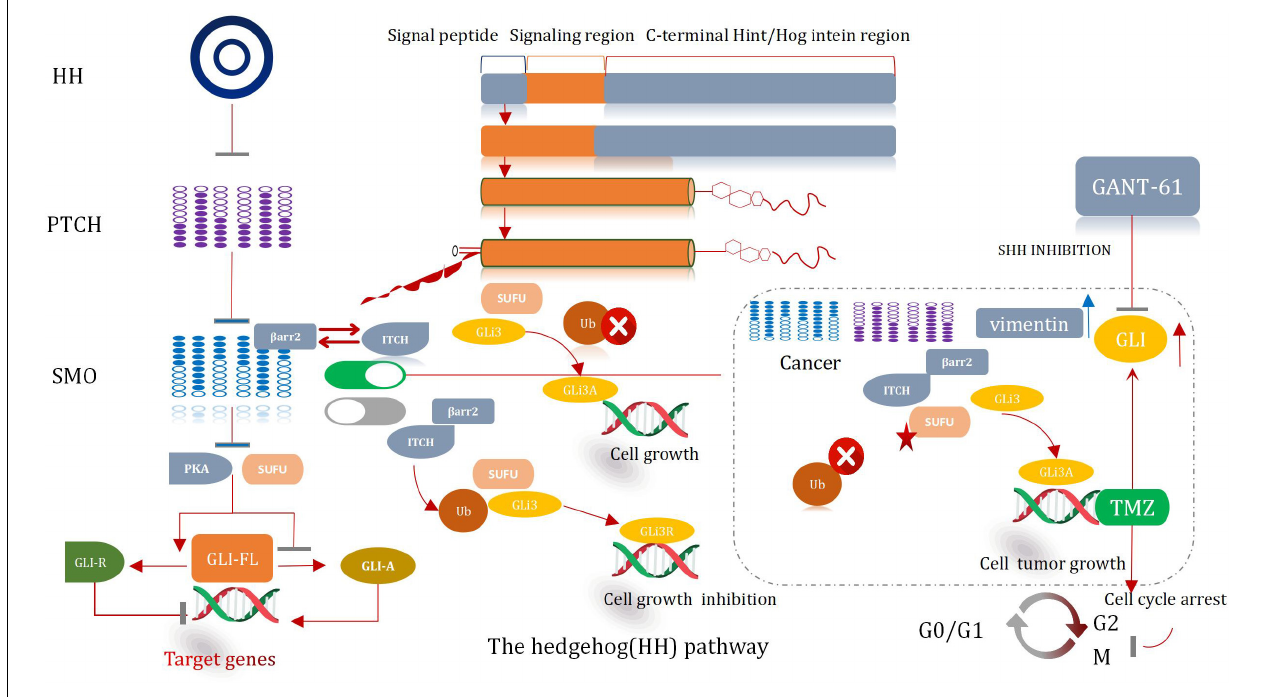
FIGURE 8 | Hedgehog signal